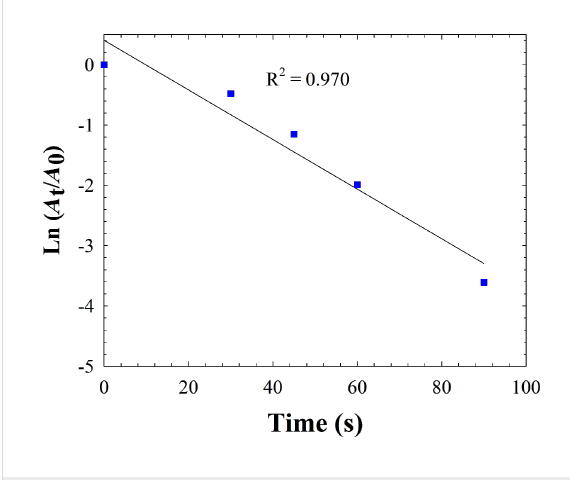
Figure 10: Plot of ln( A t / A 0 ) vs irradiation time for 4-NP reduction. Conditions: [4-NP] = 2.5 × 10 − 3 M; [NaBH 4 ] = 0.25 M; catalyst = 15